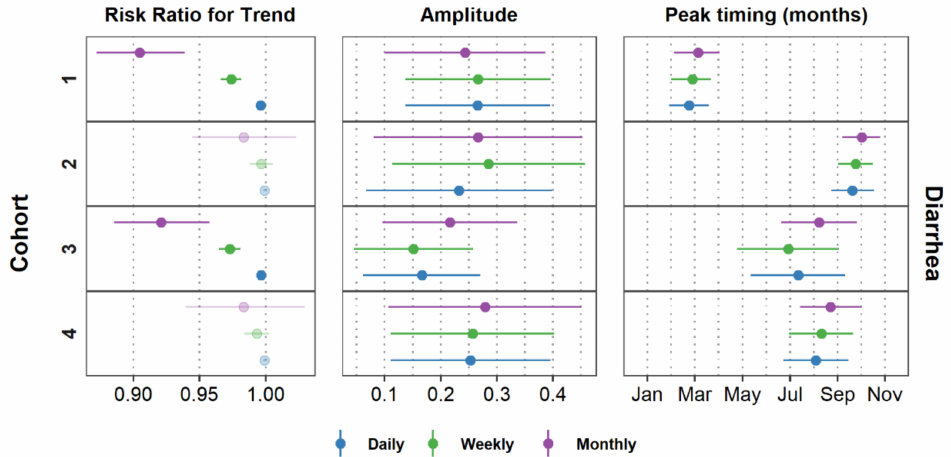
Figure 9. Estimates and confidence intervals for trend, amplitude, and peak timing of diarrhea for all aggregation levels. Faded symbols indicate estimates that had a p -value > 0.05. Estimates for ALRI and AURI are shown in Figure A1 in the Appendix